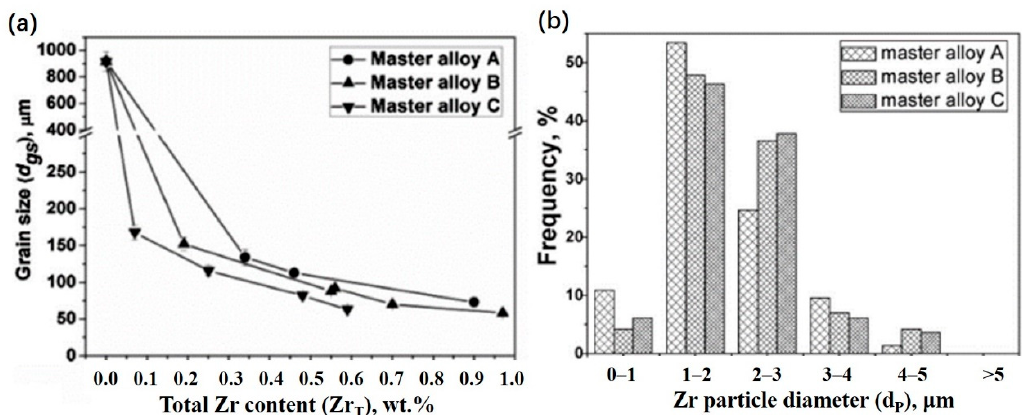
Figure 8. ( a ) The relationship between grain size ( d gs ) and total Zr content (Zr T ) for Mg-5Gd-1.5Y alloy refined using different Mg-Zr master alloys. ( b ) The distribution of Zr nuclei in Mg-5Gd-1.5Y alloy with Zr T contents of 0.46, 0.55 and 0.59, inoculated by master alloys A, B and C, respectively [26]. The microstructure and Zr particle size distributions of the Mg-Zr master alloys are shown in Figure 1. Reprinted with permission from ref. [26]. Copyright 2013 Wiley.